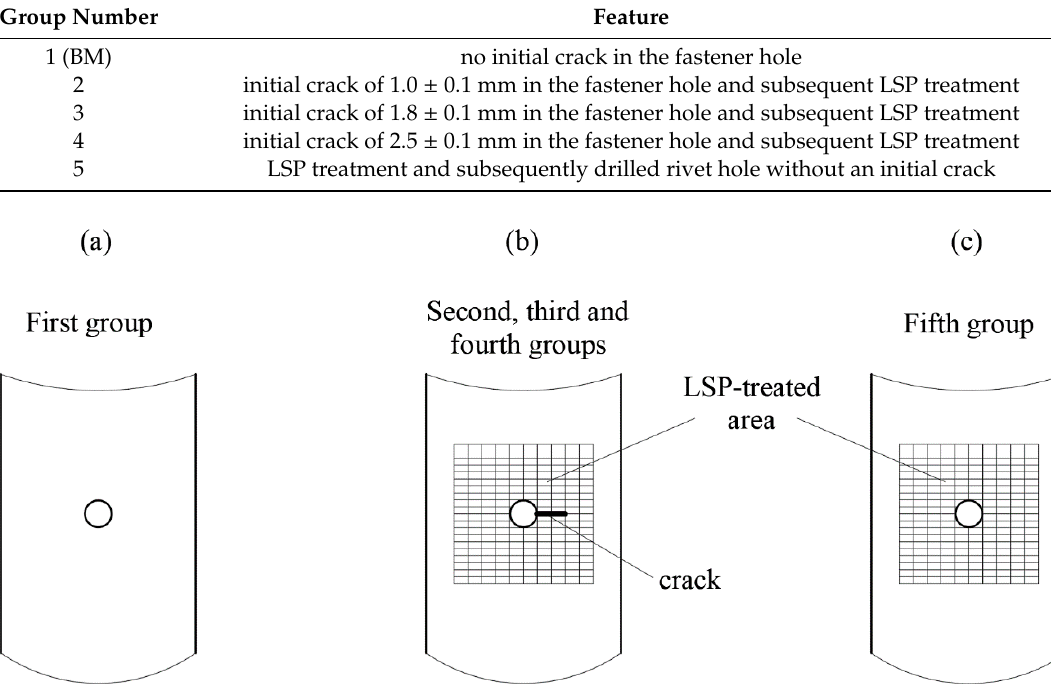
Table 1. Specifications of the specimens used in the fatigue test.